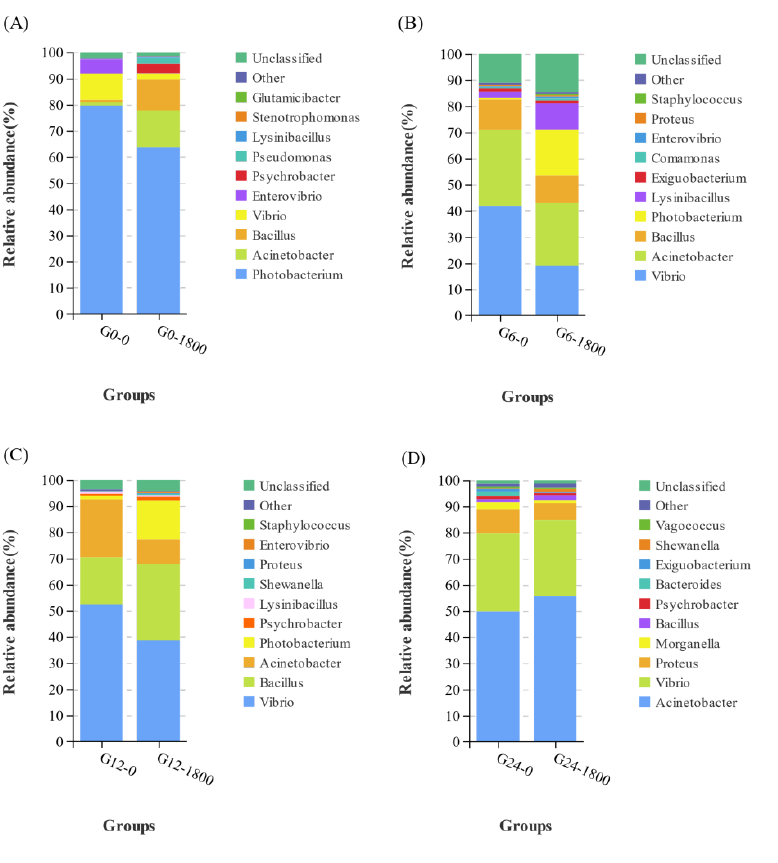
Figure 4. Effect of dietary GML supplementation on the relative abundance of Genus in grouper intestinal flora under salinity stress. ( A ), ( B ), ( C ), and ( D ) represent the relative abundance of Genus level of G0 group and G1800 group at 0 h, 6 h, 12 h, and 24 h, respectively.